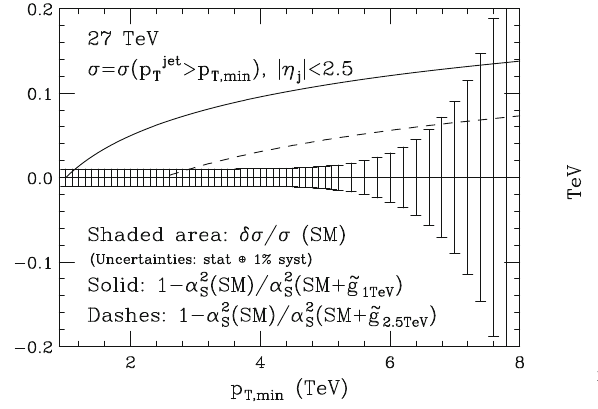
Fig. 5.8 Same as Fig. 5.5, but for HE-LHC, with 15 ab − 1 of luminosity